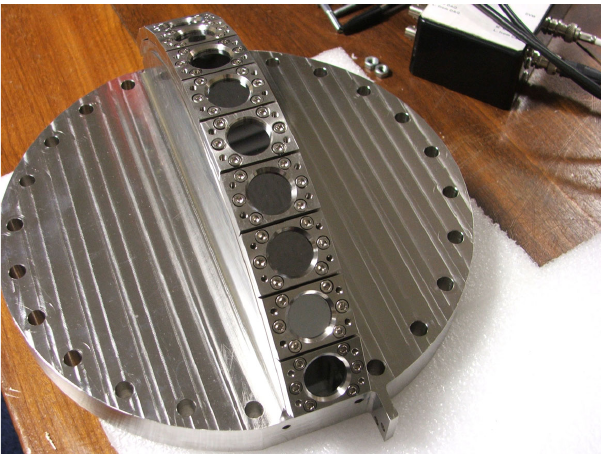
FIG. 2. Photograph of the chamber flange with the 11 silicon